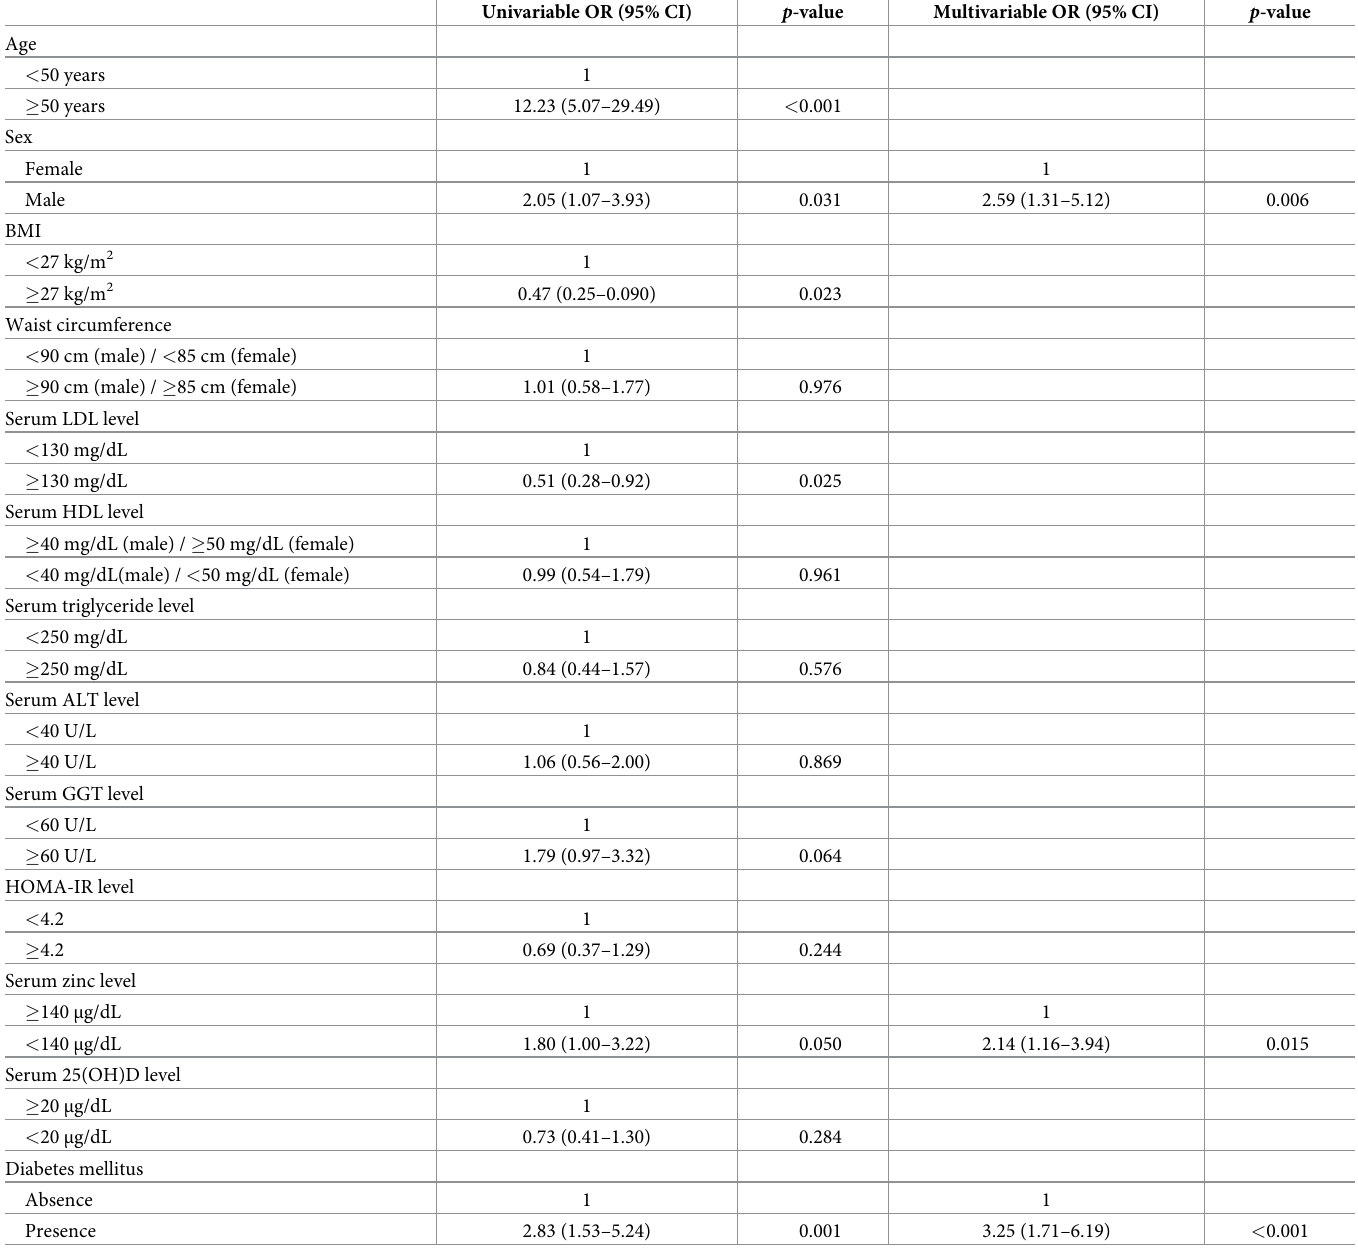
Table 2. Risk factors for significant hepatic fibrosis in subjects with